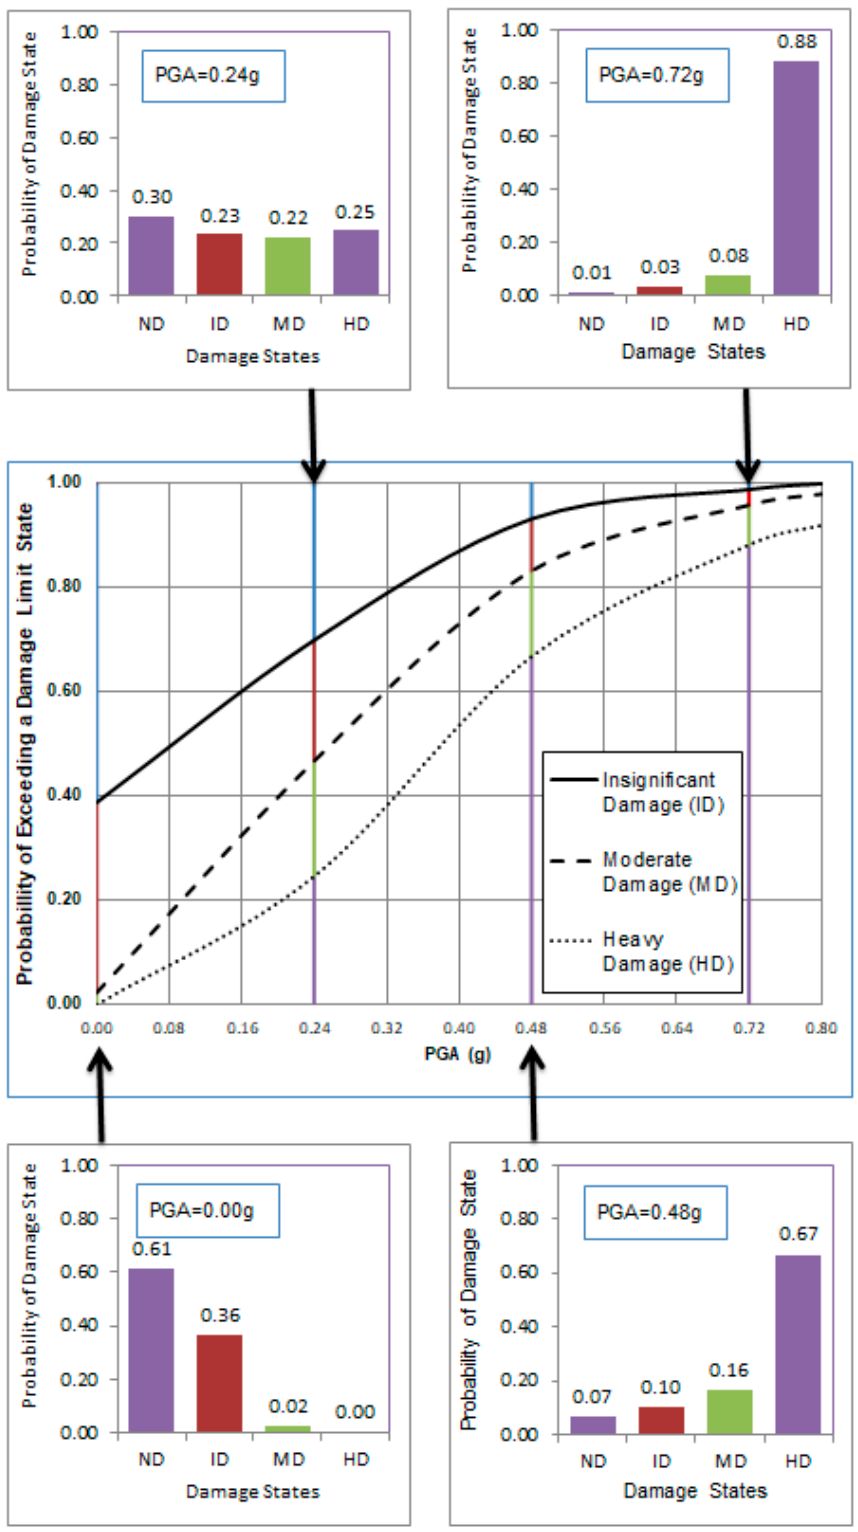
Figure 41. Derivation of fragility curves of the 2D masonry wall L50H100 (Figure 36a) with opening percentage of 16% using normal distribution and Von Mises modified failure criterion (ND, No Damage; ID, Insignificant Damage; MD, Moderate Damage; HD, Heavy Damage).